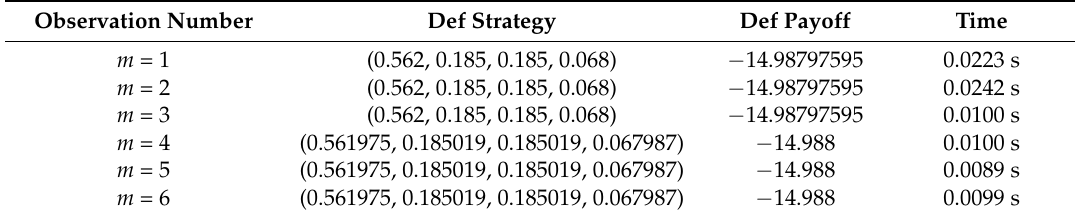
Table 5. Results computed by MAXIMIN under different observation conditions (the notation of time represents the running time of the solver and the notation of s in this table denotes